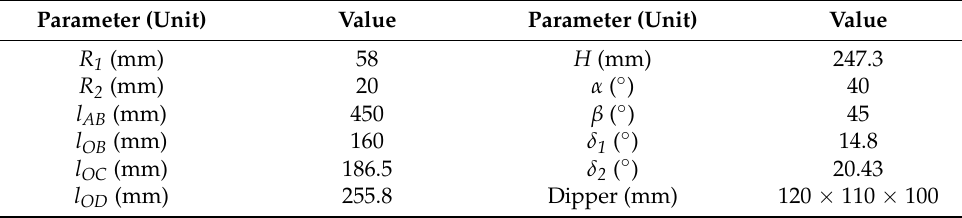
Figure 2. Structural parameters of the ECS scale model: R 1 – boom point sheave diameter; R 2 –crowd gear diameter; l AB –boom length; l OB , l OC , l OD –the distances from the rotation center of the saddle to the bottom of the boom, the hoist beam, and the tooth tip; H– height of saddle rotation center from tooth tip; α –material angle of repose; β –angle between boom and horizontal direction; δ 1 , δ 2 –angle between l OD , l OC and the parallel direction of the dipper handle. Table 1. Structural parameter values.